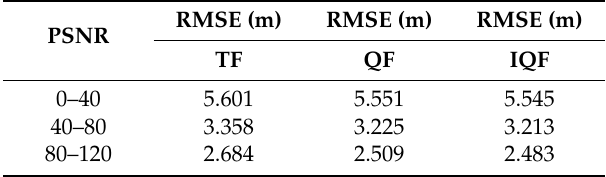
Table 5. The PSNR distribution of the averaged RMSE values for the three algorithms.